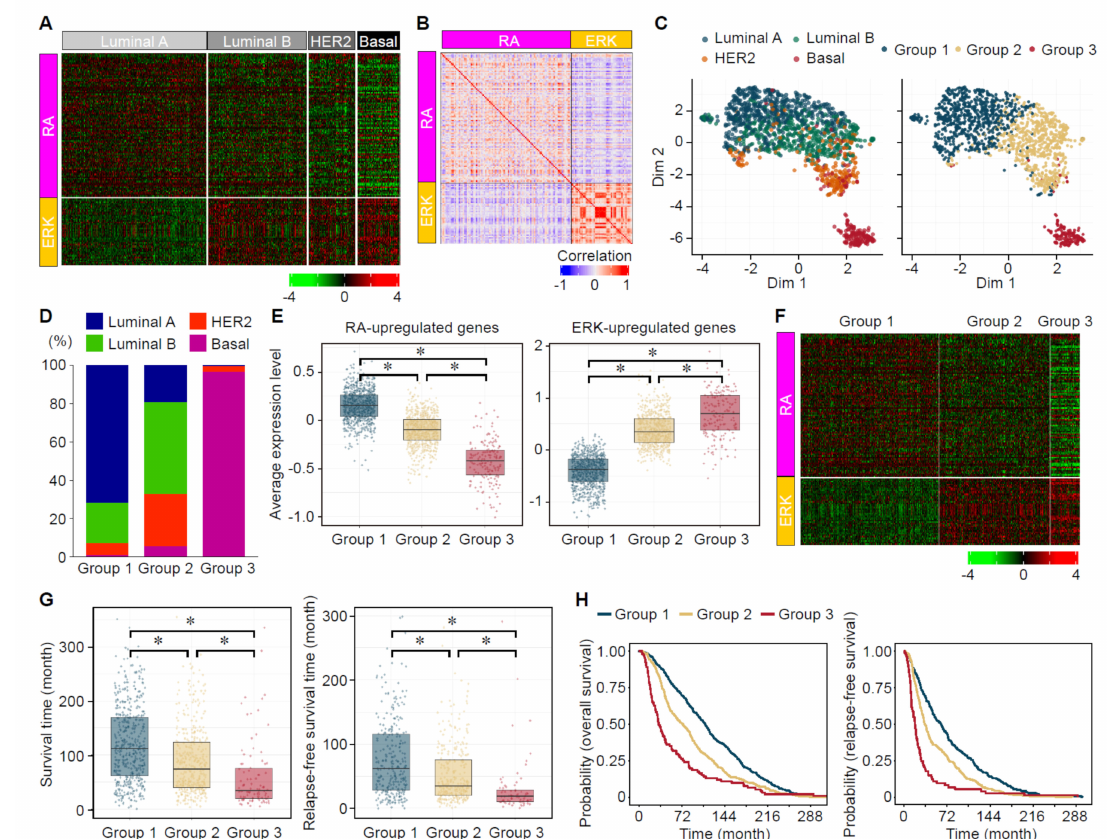
Figure 7. Expression profiles of RA- and ERK-target genes in human breast cancers. ( A ) Expression profiles of the RA- and ERK-dependent upregulated genes in major subtypes of breast cancers (Luminal A: n = 678, Luminal B: n = 461, HER2: n = 219, Basal: n = 199) are shown ( Z scores). ( B ) Correlation matrix of the expression levels of the RA- and ERK-dependent upregulated genes in breast cancers ( n = 1557). Pearson correlation coefficient of pairwise correlation of each gene was shown according to the color scale. ( C ) UMAP dimensionality reduction of breast cancer patients based on the expression levels of RA- and ERK-dependent upregulated genes. Patients were clustered into three groups (right), which were composed of different combination of breast cancer subtypes (left). ( D ) Proportion of breast cancer subtypes among the groups. ( E ) The average expression levels of the RA- and ERK-upregulated genes among the groups. *, p < 0.05 (Krukal-Wallis test followed by Wilcoxon rank sum test). ( F ) Expression profiles of the individual RA- and ERK-dependent upregulated genes among the groups. ( G ) Survival and relapse-free survival times of breast cancer patients among the groups. *, p < 0.05 (Krukal-Wallis test followed by Wilcoxon rank sum test). ( H ) (left) A Kaplan–Meier survival curve for breast cancer patients who died of the cancer ( n = 933). (right) A relapse-free survival curve for the breast cancer patients who had the cancer recurrence ( n = 643). Survival and relapse-free survival curves for all the patients are also provided in Figure S2. Statistical differences were observed between all possible pairs of survival and relapse-free survival curves by log-rank tests, with p values less than